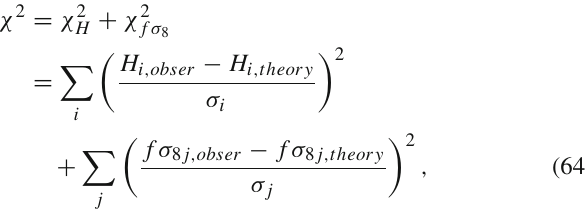
Fig. 6 The evolution of f σ 8 ( z ) as a function of the redshift z for three different values for the constant η = − 0 . 02 (dot-dashed), η = 0 (dashed) and η = 0 . 1 (dotted). We use the best fit values for the model parameters presented in Table 2. The (cid:2) CDM curve is depicted as a red